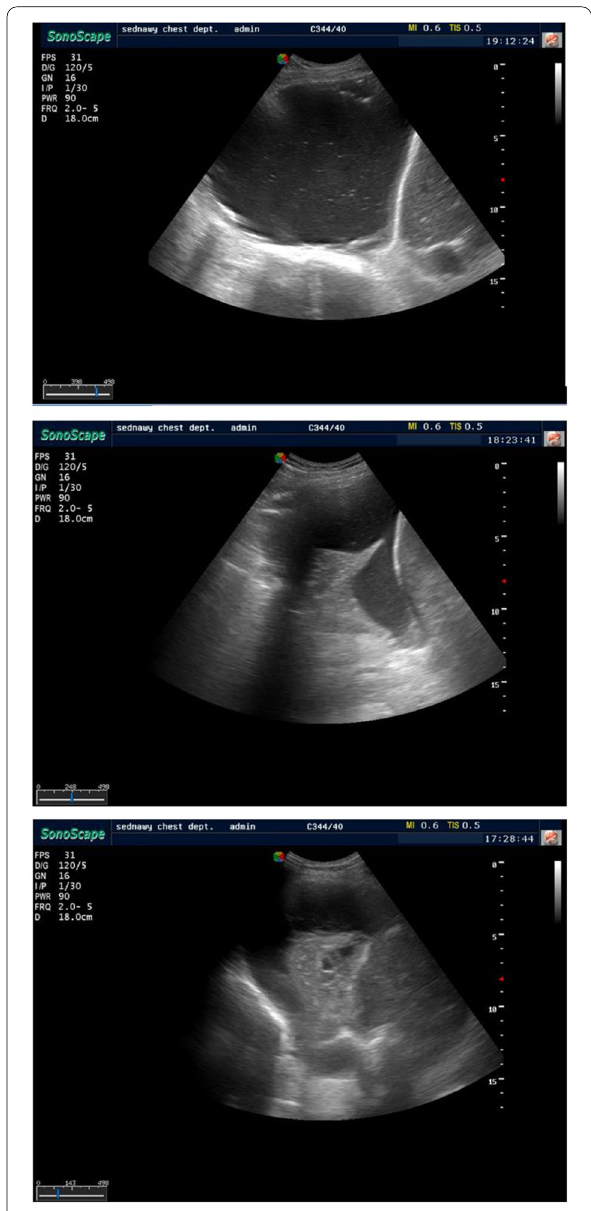
Fig. 2 The chest ultrasound patterns of empyema patients. Top left: A group (I) —complex non-septated and relatively hyperechoic pattern. Top right: B group (II) or group (III) —complex septated effusion (either fixed or mobile septa). Bottom: C group (IV) — homogenously echogenic pattern, with echogenic spot density in the pleural